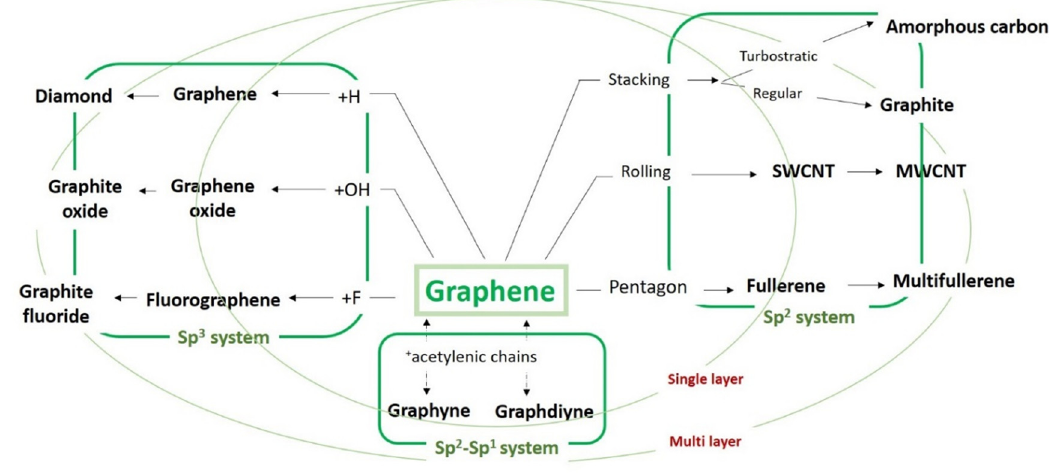
Figure 4: Schematic diagram of the development of graphene and its derivatives. Adapted from ref. [ 38 ]